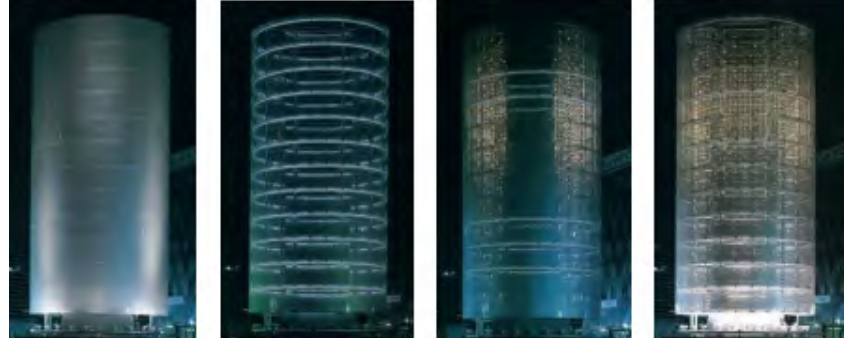
Figure 3. Tokyo Ito, Tower of winds, Yokohama 1986; (Wachlowski,